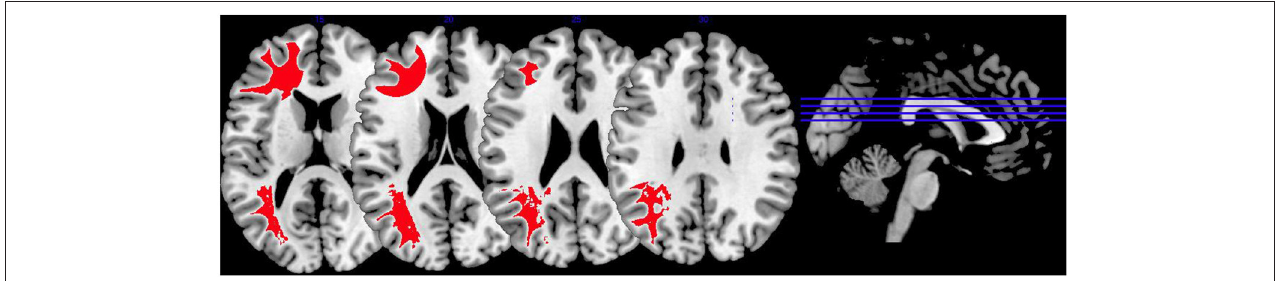
FIGURE 5 | Affective theory of mind activations. Overview of the affective theory of mind brain activation patterns reported by the reviewed studies, the group comparison being VS vs. NVS in the contrast of mental state attribution vs. gender discrimination. Here, we show the hyperactivation of VS > NVS in red (shown slice numbers are 170, 180, 190, 200).